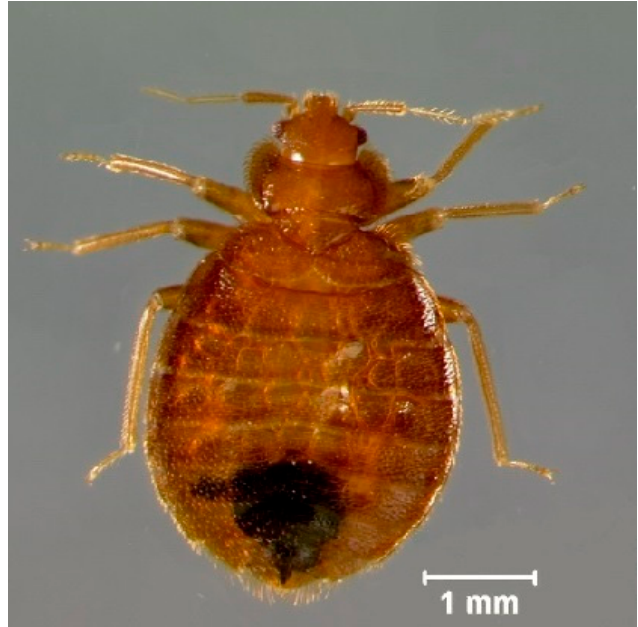
Figure 3. Sublethal effect following topical application of 0.0016% ( w / v ) lufenuron on a Harlan strain bed bug. Complete ecdysis occurred; however, the bed bug could not properly walk and could not fold its legs underneath its body.